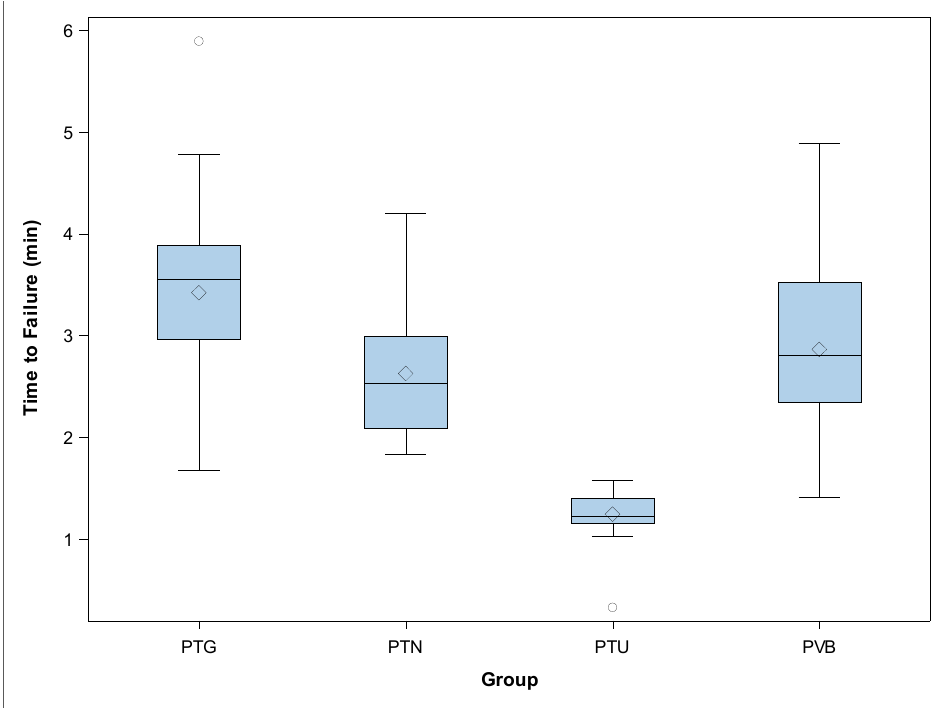
Figure 3. Box plot of the time to failure. The horizontal line in each box represents the respective median value of the study groups. ♦ ; Mean value of the box plots. PTU: ProTaper Universal; PTN: ProTaper Next; PTG: ProTaper Gold; PVB: ProFile Vortex Blue.